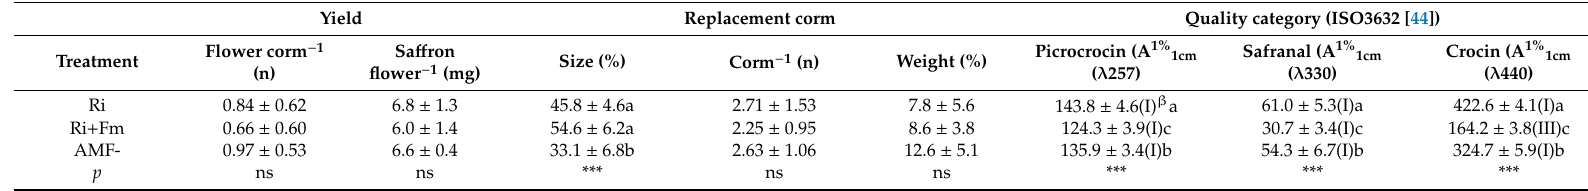
Table 2. E ff ects of AMF inoculum composed of Rhizophagus intraradices alone (Ri), R. intraradices and Funneliformis mosseae (Ri + Fm) or the control (AMF-) on yield performances (flower corm − 1 and sa ff ron flower − 1 ), growth (number of replacement corms corm − 1 ; replacement corm size and weight variation between the end and beginning of the trial) and mean absorbance values for picrocrocin, safranal and crocin of sa ff ron samples obtained during glasshouse cultivation.